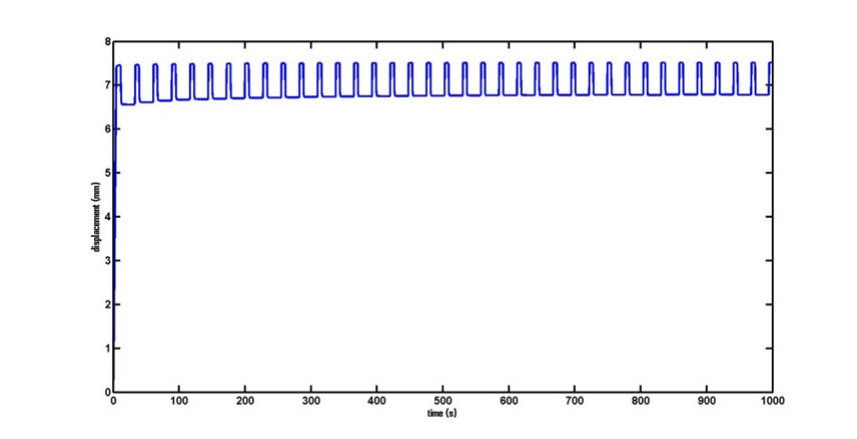
Fig. 6 Initial cycles of test with a hold time of 5 seconds at maximum and 20s at minimum load.